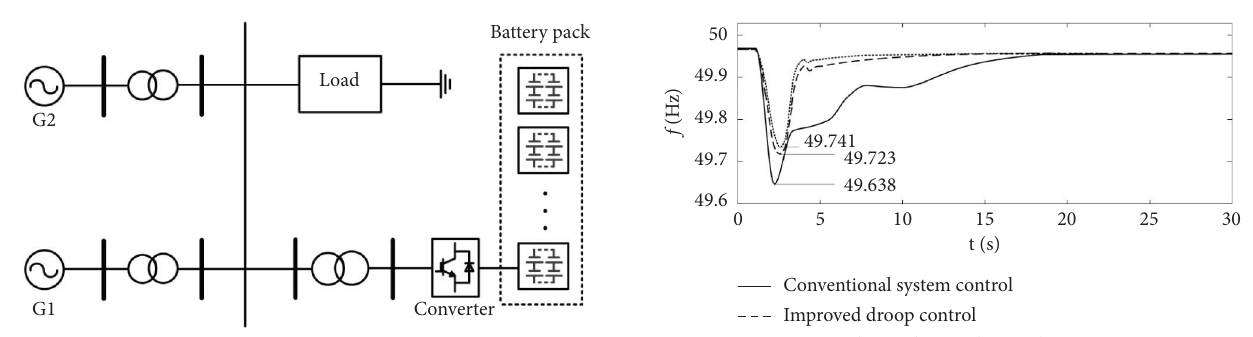
Figure 5: Battery energy storage system simulation.